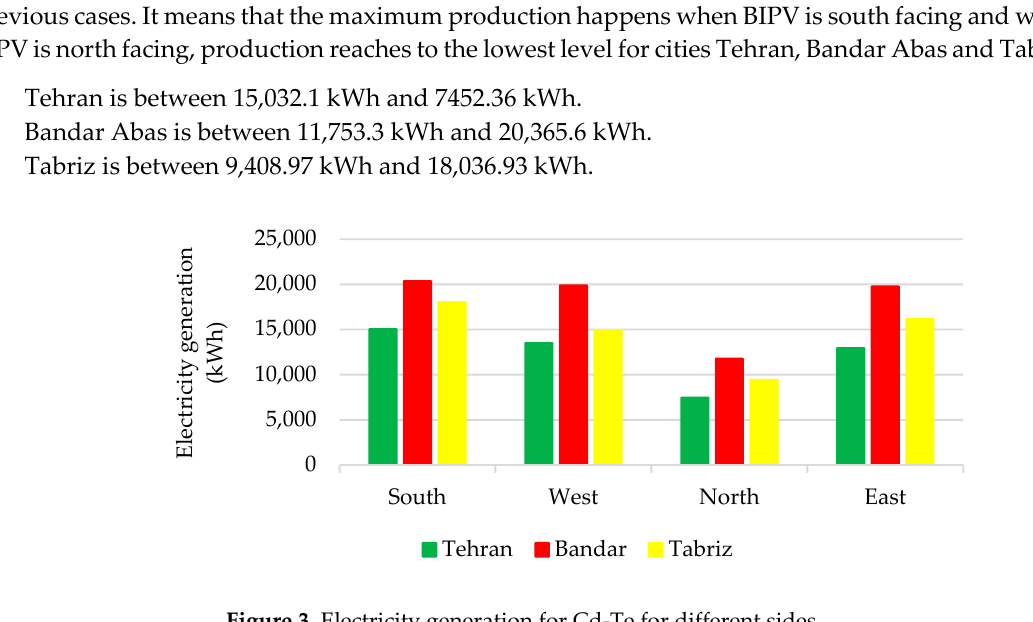
Figure 3. Electricity generation for Cd-Te for different